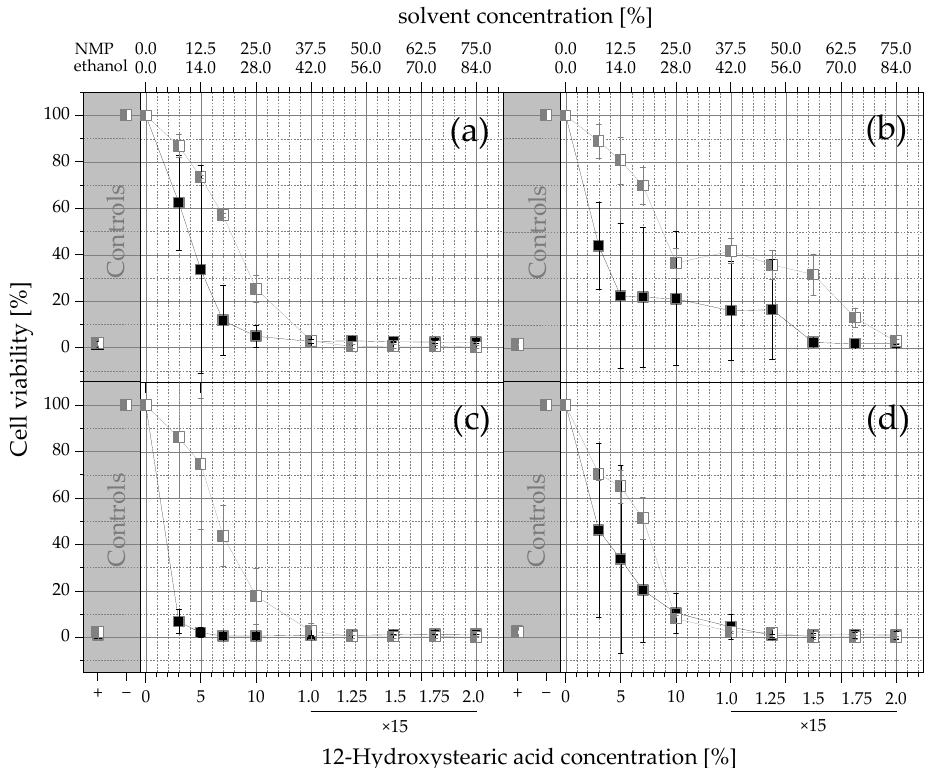
Figure 5. Acute toxicity–cell viability levels after exposure to solvents: ( a ) 3T3 cells after 24 h; ( b ) NHDF cells after 24 h; ( c ) 3T3 cells after 96 h; ( d ) NHDF cells after 96 h. Positive and negative controls for each assay are provided in the gray sections to demonstrate the performance of the experimental design. The cells were treated with solutions of NMP (PO ISFOs) and ethanol (MCT and IPM ISFOs) . The viability values are given as a function of the solvent concentration and the corresponding 12-HSA concentration, and as arithmetic mean ± SD; n = 3. Since no higher 12-HSA concentrations than 15% were tested, the amount of ISFO injected into the extraction medium was increased for the last 4 datapoints (250, 300, 350, and 400 µL into 800 µL of medium; for all other datapoints 200 µL was injected into 800 µL).